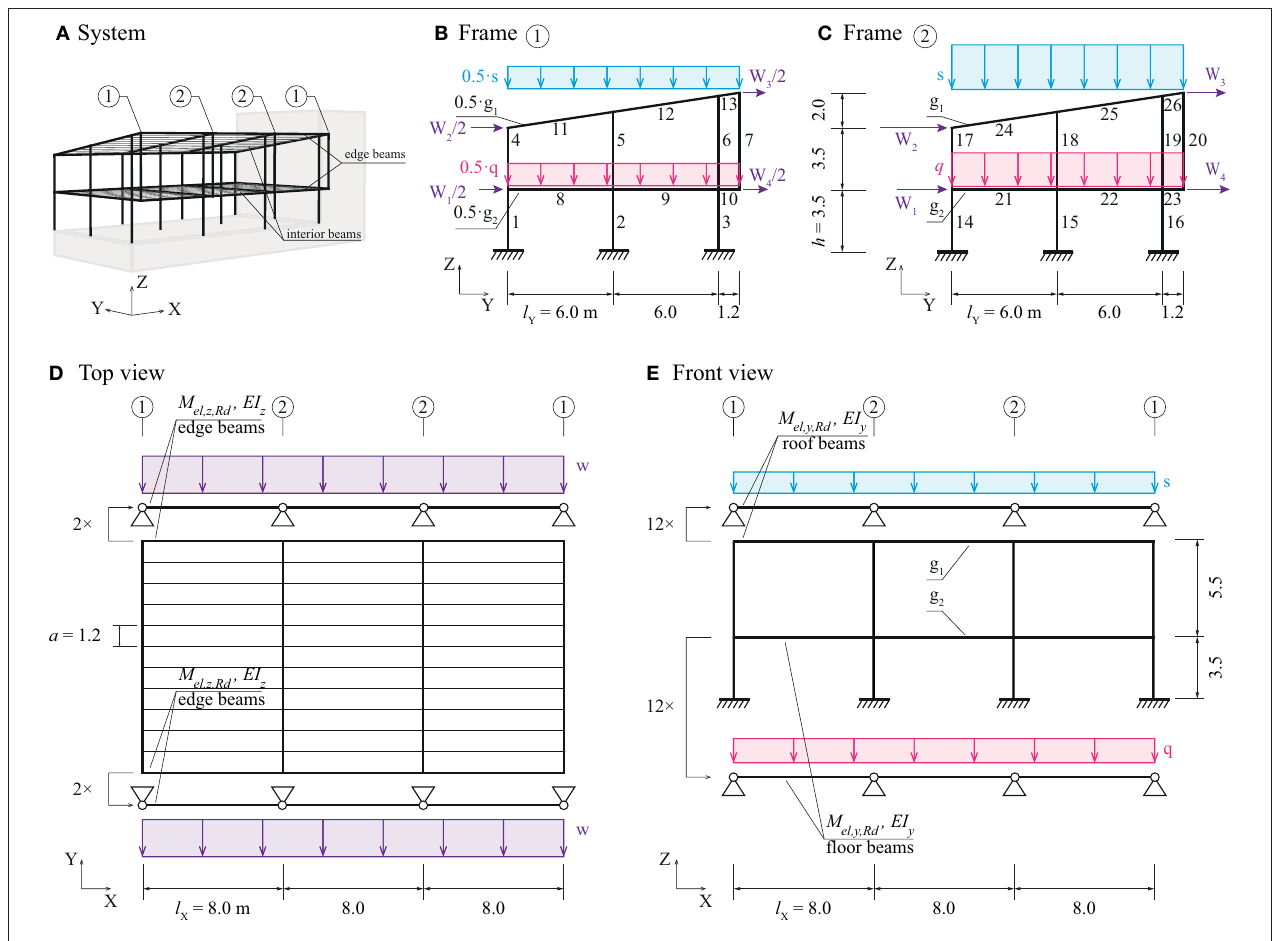
FIGURE 8 | Office building structure: (A) layout, (B) end frame in Y-Z plane, (C) internal frame in Y-Z plane, (D) top view, (E) front view.